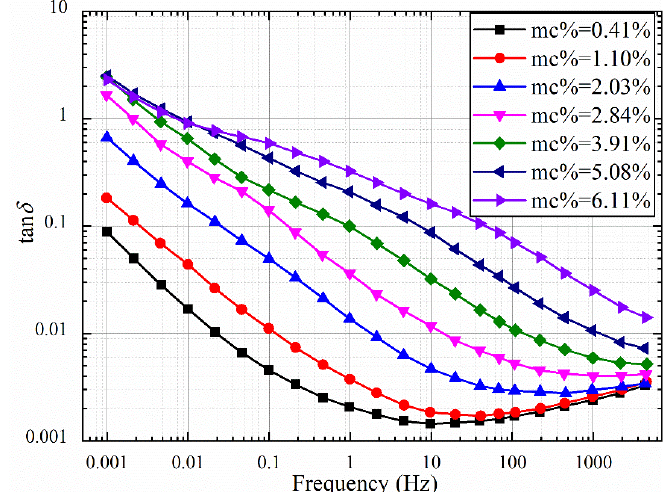
Figure 4. tan δ - f curves with different moisture contents.